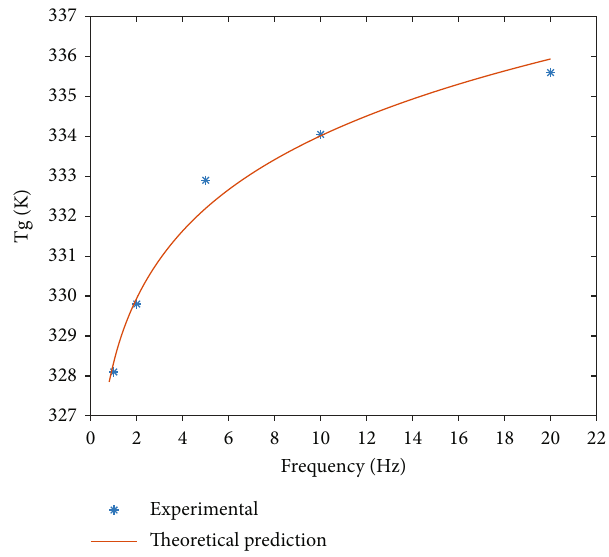
Figure 8: Glass transition temperature prediction with a corrected value of N